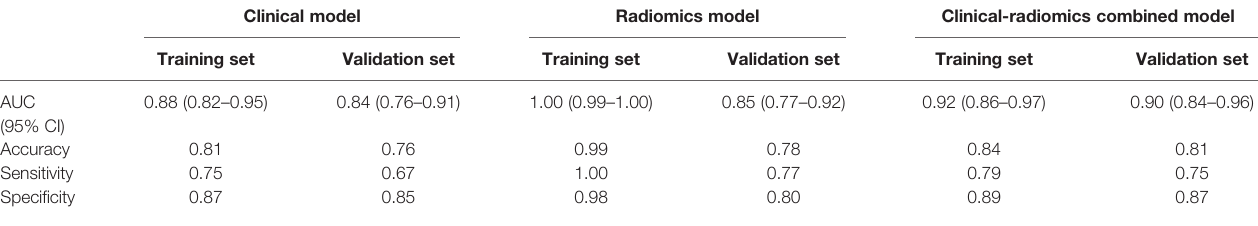
TABLE 3 | AUC results of the clinical, radiomics, and clinical-radiomics combined models for predicting PCa.